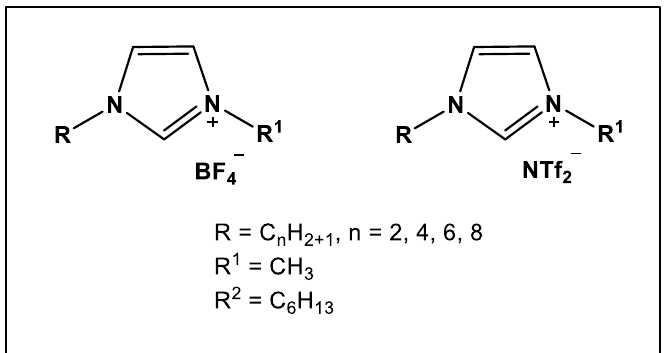
Figure 14. Structure of imidazolium ILs with variable alkyl chain. In 2018, the lubricating ability of PILs on aluminium–steel contact was studied by the use of tri-[bis(2-hydroxyethylammonium)]citrate (DCi) (Figure 15) as an additive to mineral oil (MO) [111].